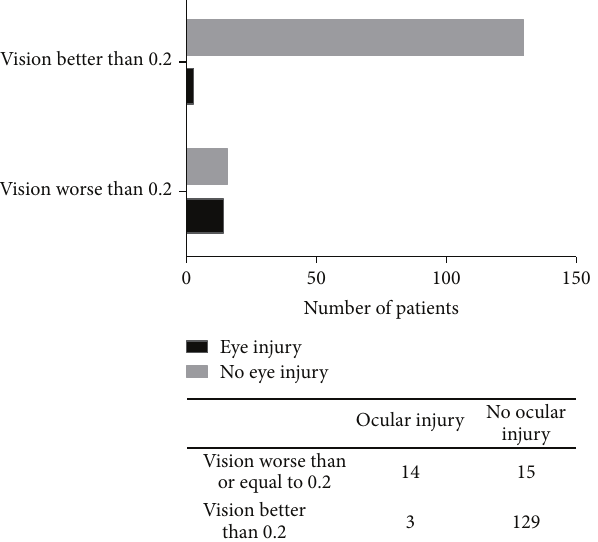
Figure 3: 14 of 17 subjects with coexistent orbital fractures and ocular injuries had habitual visual acuities worse than or equal to 0.2 LogMAR. Habitually corrected visual acuity worse than or equal to 0.2 was 82% sensitive and 90% specific for ocular injury, with a negative predictive value of